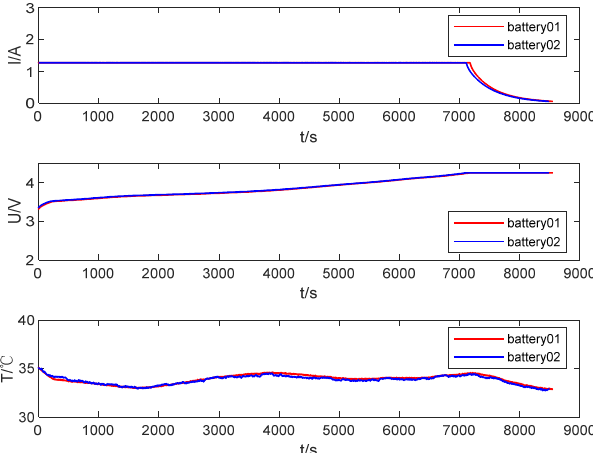
Figure 13. The experimental results of the constant current–constant voltage charging